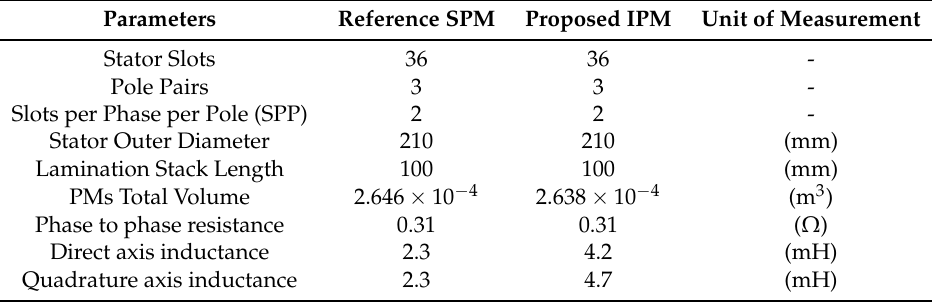
Table 1. Characteristics of reference surface permanent-magnet (SPM) and proposed interior permanent-magnet (IPM) motors.